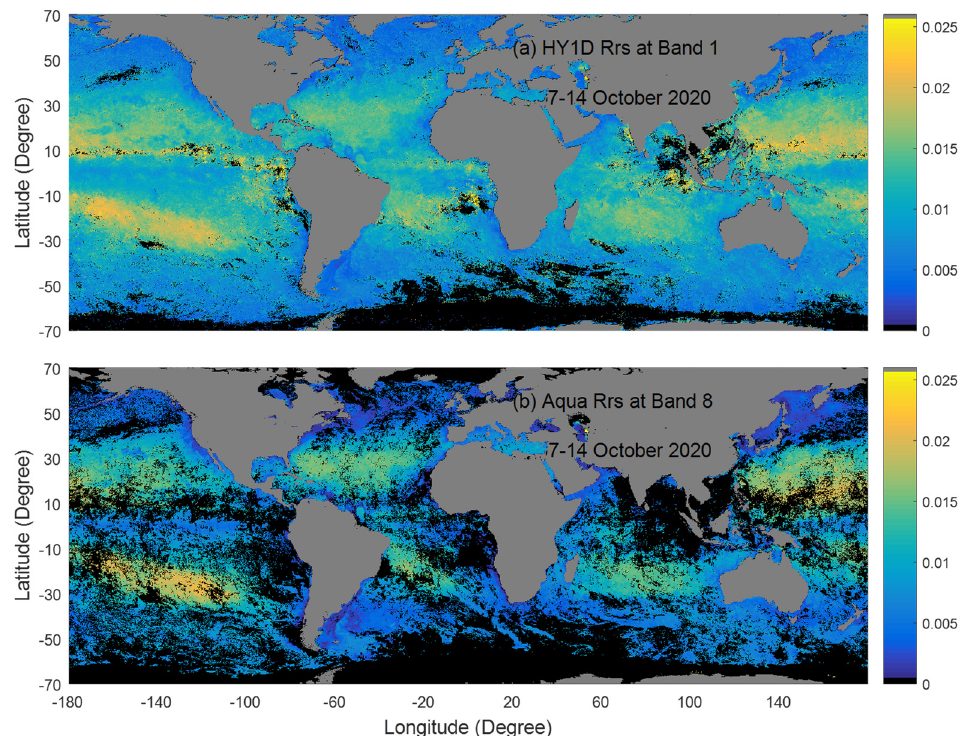
Figure 9. The comparison of the 8-day composite R rs image between COCTS/HY-1D at Band 1 ( a ) and MODIS/Aqua at Band 8 ( b ). Both are produced from the global daily images during the period of 7 to 14 October 2020. The magnitudes of image pixels are indicated by the color bar with the unit of sr − 1 . Invalid pixels are masked black and land grey.